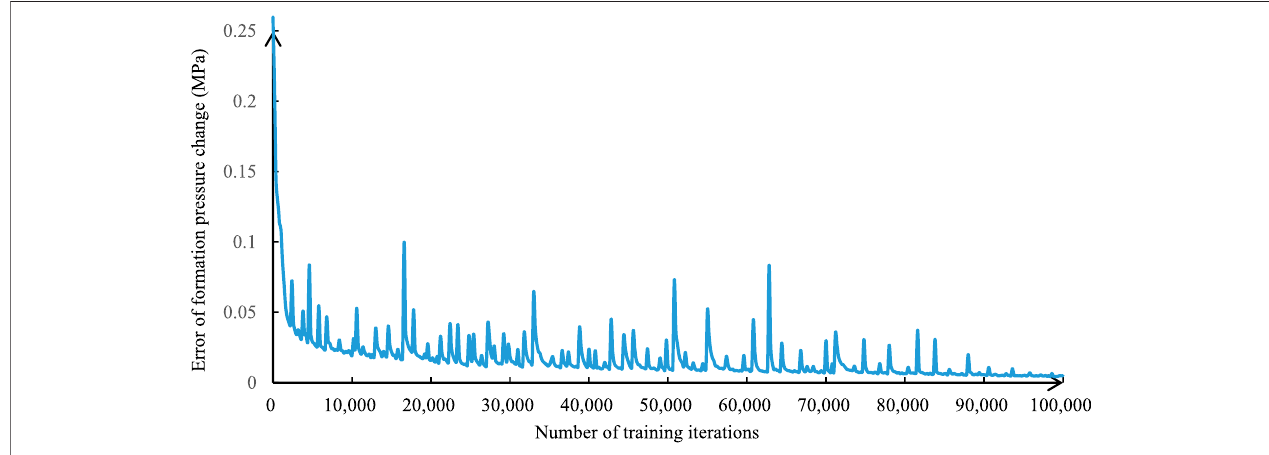
FIGURE 11 | Average error of formation pressure change based on test samples with the number of training iterations.